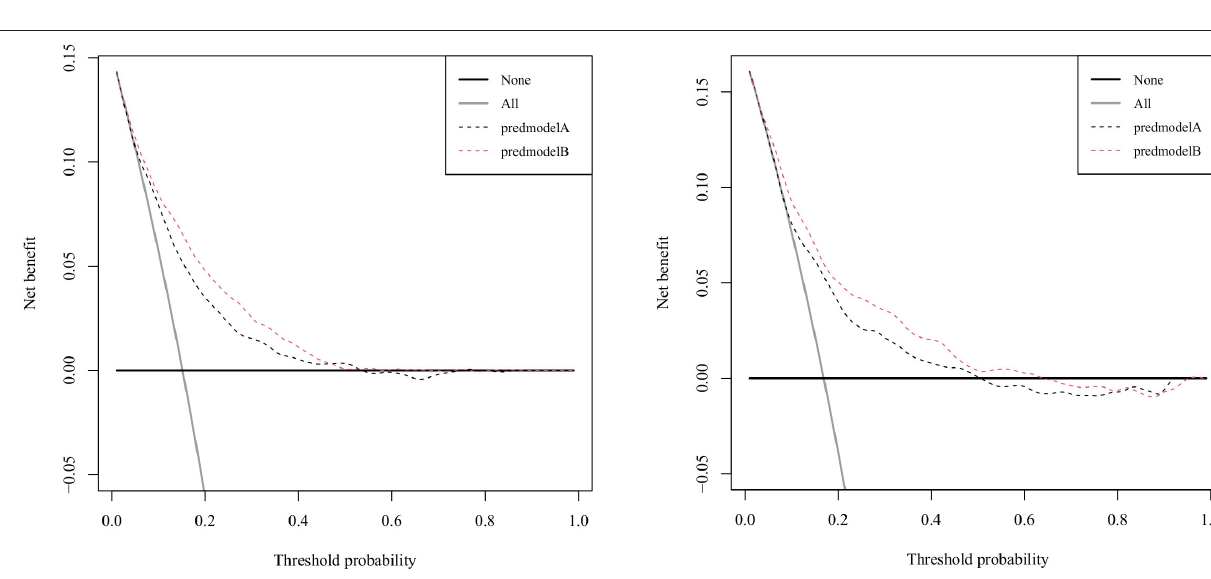
FIGURE 4 | Decision-curve analysis of the validation cohort and the training cohort. Model A represents the APSIII model, and model B represents the